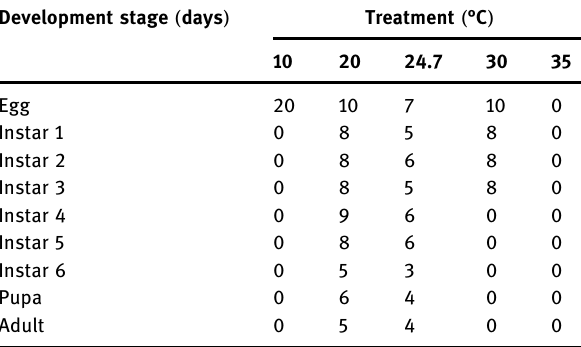
Table 1: Life cycle length ( N° of total days/stage ) of D. busckella